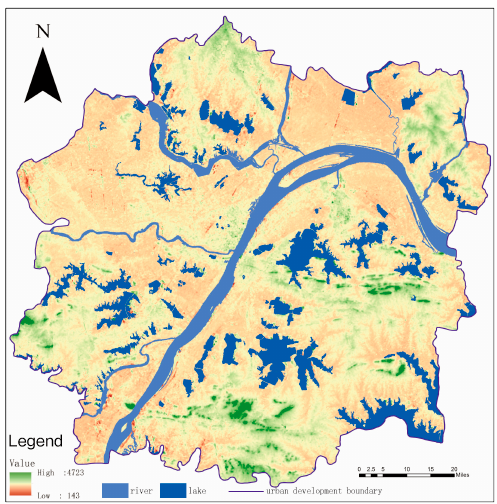
Figure 1. ( a ) Location overview of Wuhan City; ( b ) relatively dispersed lake distribution that is mainly concentrated in the central and southern parts of Wuhan. Many small lakes form around the main rivers, and the urban area enjoys abundant water resources.